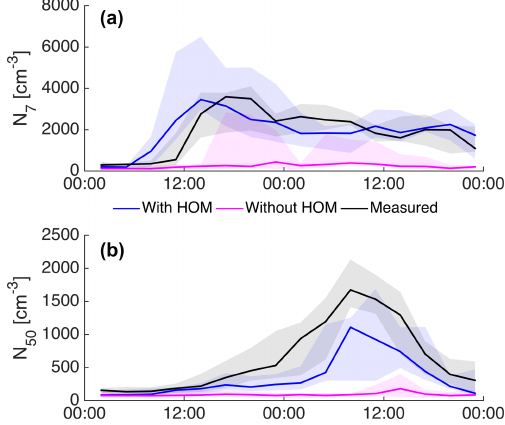
Figure 6. Modelled and measured (a) N 7 and (b) N 50 . The model results are shown for simulations with and without HOM formation via the autoxidation of monoterpenes (blue and pink lines, respec- tively). The solid lines show the median values from 10 NPF events at Pallas. The shaded areas give the 25% to 75%